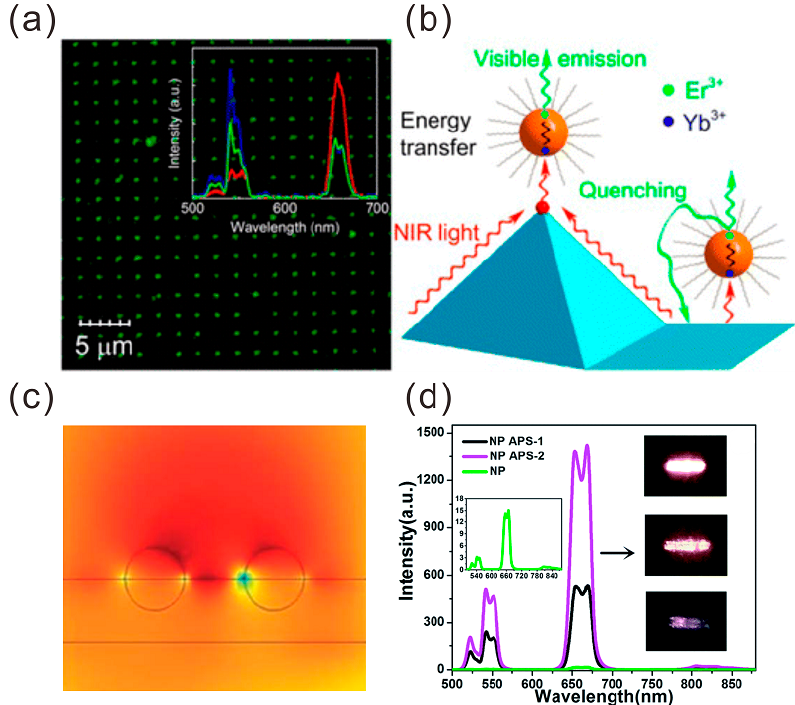
Figure 8. ( a ) Confocal images for the green emission on 29-nm NaYF 4 :Yb 3+ /Er 3+ particles. ( b ) Schematic of the energy transfer, upconversion, and quenching processes on the top and bottom of the gold pyramid substrate. The ultrasmooth gold pyramid provides a good platform to study all of these photophysical processes in the doped-lanthanide NPs. Adapted from [59], with permission from © 2014 American Chemical Society. ( c ) Simulated electric field distributions. ( d ) Comparison of emission spectra of NaYF 4 :Yb 3+ and Er 3+ NPs deposited on the quartz substrate (green line), Au papilla surface type 1 (APS-1) (black line), and Au papilla surface type 2 (APS-2) (pink line). Insets are the optical images of the NaYF 4 :Yb 3+ and Er 3+ NPs spin-coated on the quartz substrate (down), APS-1 (middle), and APS-2 Au films (up). Adapted from [60], with permission from © 2016 RSC Publishing.